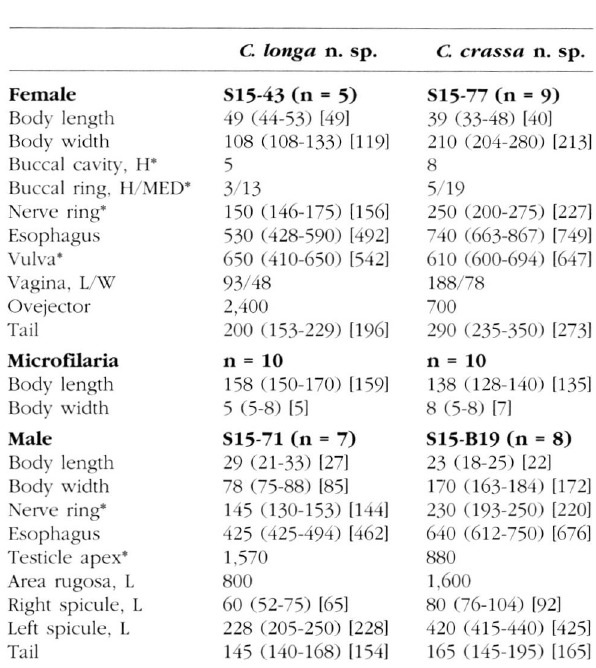
at 7.0 mm, and the fourth at 19 -6 mm in the holotype specimen; a pseudocoelomocyte was present in each swelling (Fig. 11 - J). Cuticular striations perpendicular to the long axis of the body in the lateral field visible by SEM, 0.5 pm apart (Fig. 5A). Body cuticle thickened internally laterally (Fig. 1J,